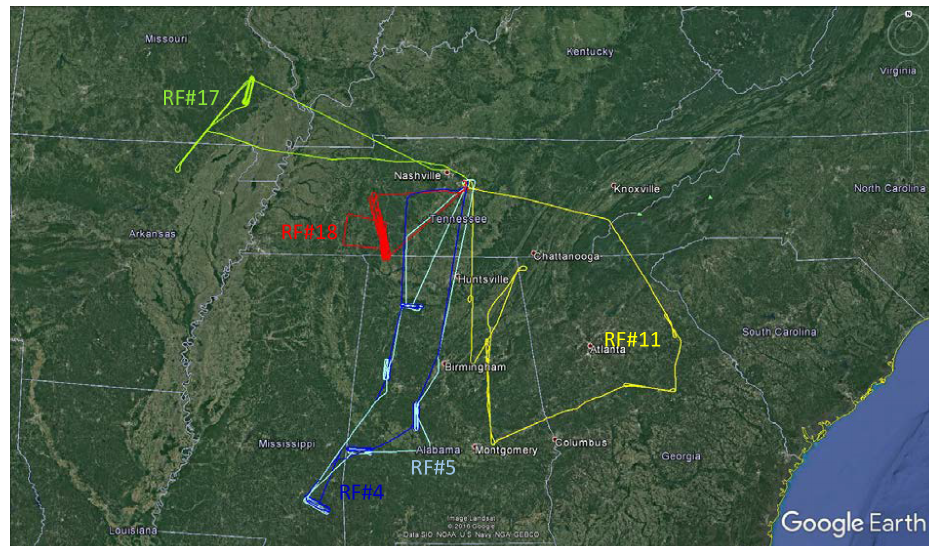
Figure 1. Flight tracks in the southeastern US during the NOMADSS 2013 summer study. The flight start time and end time in UTC ( = EDT + 4) are for RF 4 (blue): 15:12 and 22:30, 12 June 2013; RF 5 (light blue): 15:04 and 21:52, 14 June 2013; RF 11 (yellow): 15:20 and 21:02, 29 June 2013; RF 17 (green): 15:07 and 21:57, 11 July 2013; and RF 18 (red): 20:32, 12 July 2013 and 03:37, 13 July